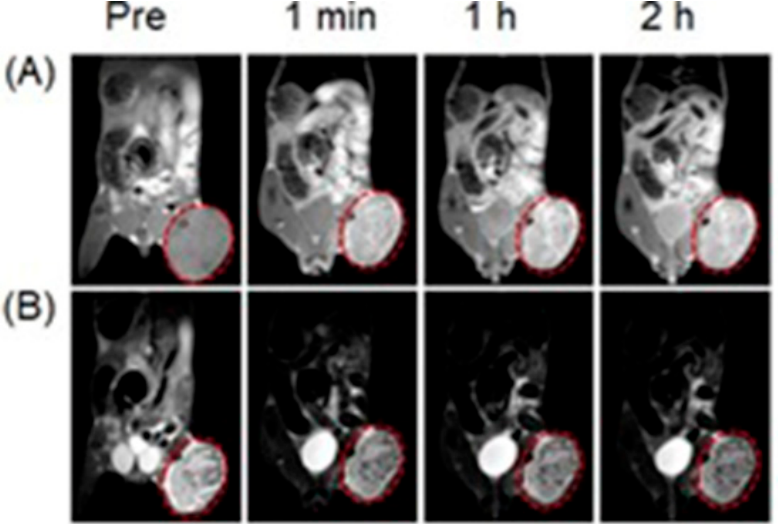
Figure 62. ( A ) T 1 - and ( B ) T 2 -weighted MRI of tumor-bearing mice obtained before (Pre) and after (1 min, 1 h, and 2 h) intravenous injection of nanocrystals. Red dotted circles represent the tumor sites. Adapted from Biomaterials , 101 , Kim, M.-H.; Son, H.-Y.; Kim, G.-Y.; Park, K.; Huh, Y.-M.; Haam, S. Redoxable heteronanocrystals functioning magnetic relaxation switch for activatable T 1 and T 2 dual-mode magnetic resonance imaging. 121–130, Copyright 2016, with permission from Elsevier [379].